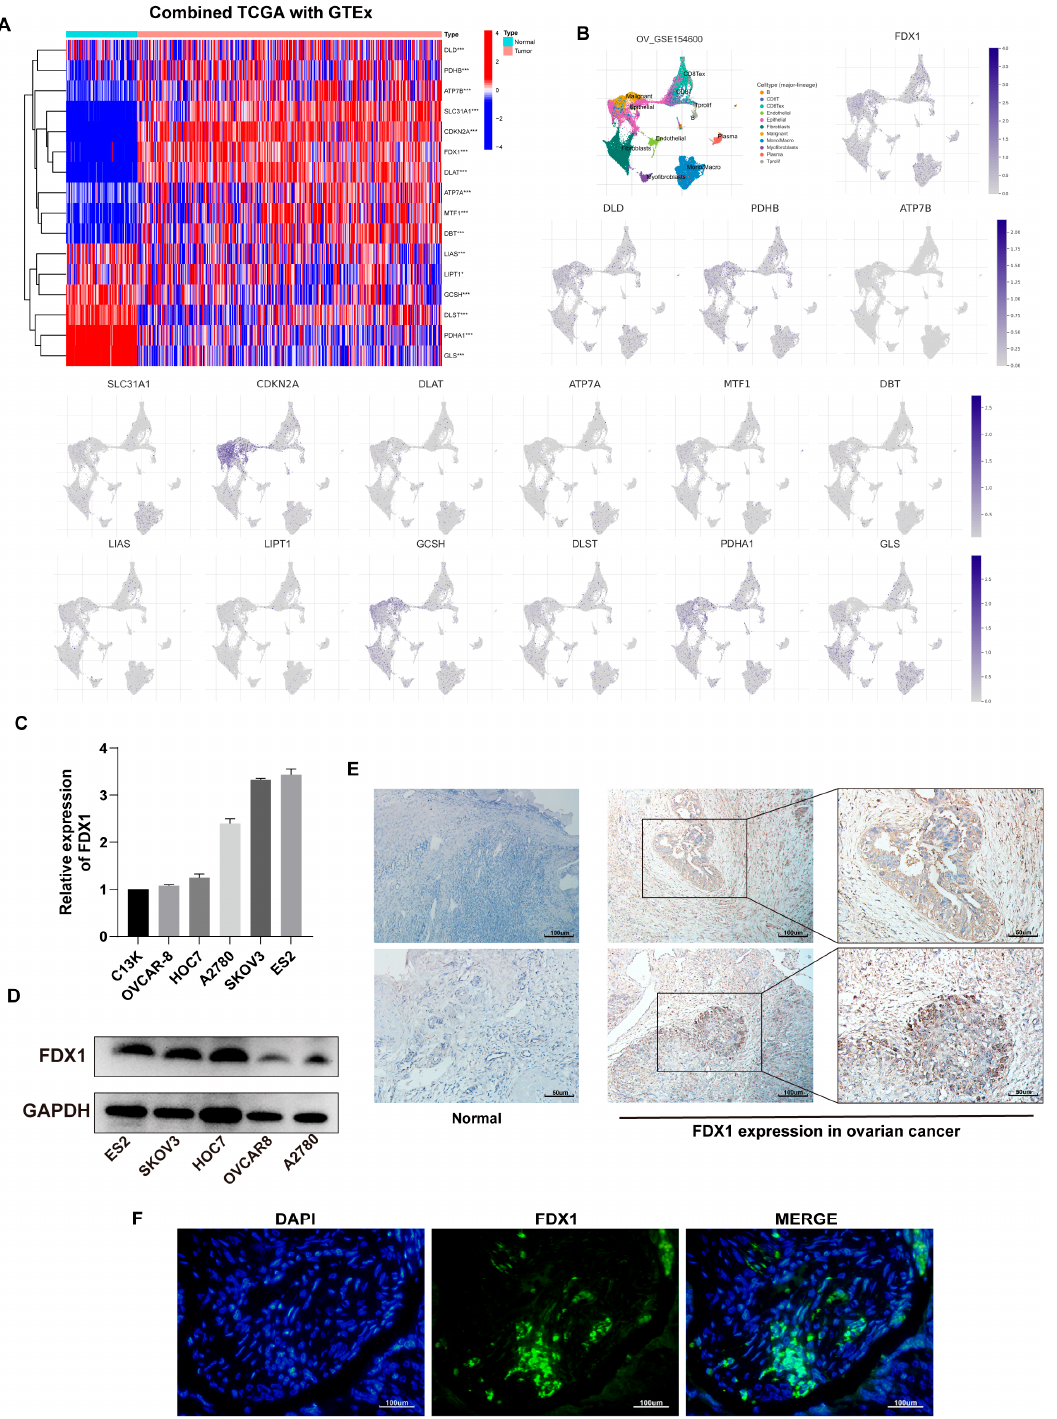
Figure 2. Expression of CRGs in OV. ( A ) Differential profile of expression of 16 CRGs in TCGA-OV and GTEx-ovary. ( B ) Expression of 16 CRGs at the cellular level based on GSE156400. ( C ) FDX1 expression in ovarian cell lines at the transcriptional and ( D ) protein levels. Immunohistochemical staining ( E ) and immunofluorescence ( F ) results of FDX1 protein in OV and normal samples. Original blots see Supplementary File S1.